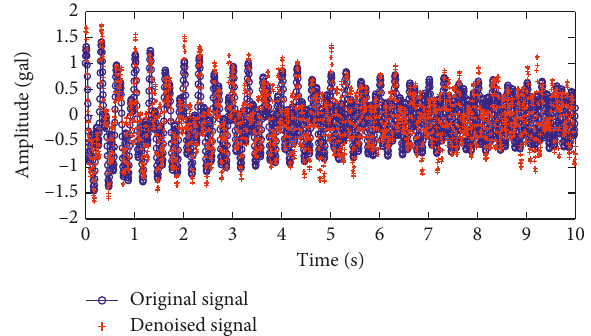
Figure 5: Comparison figure of original signal and denoised signal using EEMD-Wavelet.